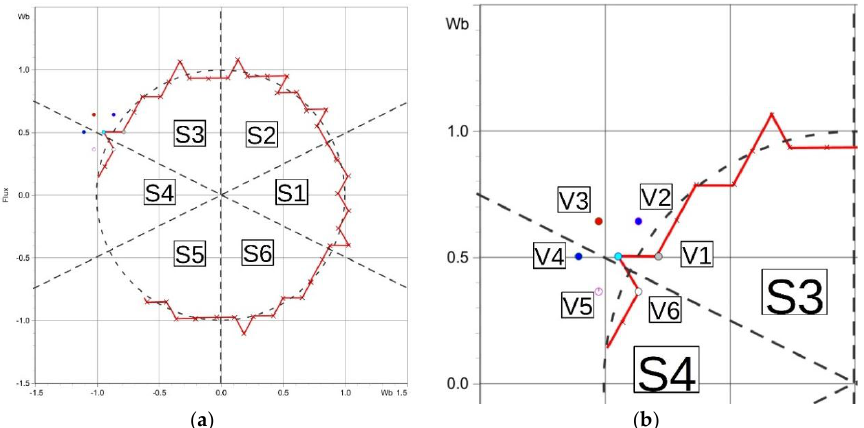
Figure 7. ( a ) The part of the flux vector tip trajectory in the PTC run; ( b ) The detail of the sector transition. At a marked point the voltage, vector V6 is applied in order to decrease flux amplitude and increase torque. The wrong vector V5 would be chosen according to Table 1 in the DTC